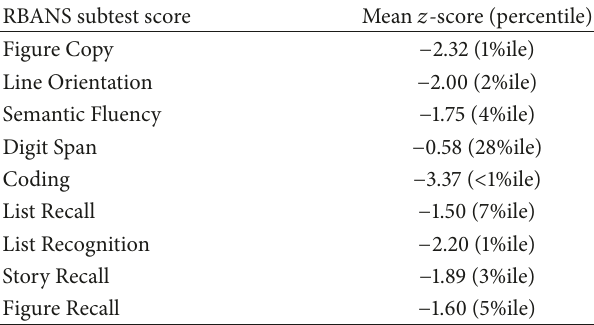
Table 2: Patients referred for neuropsychological assessment, 𝑛 = 126